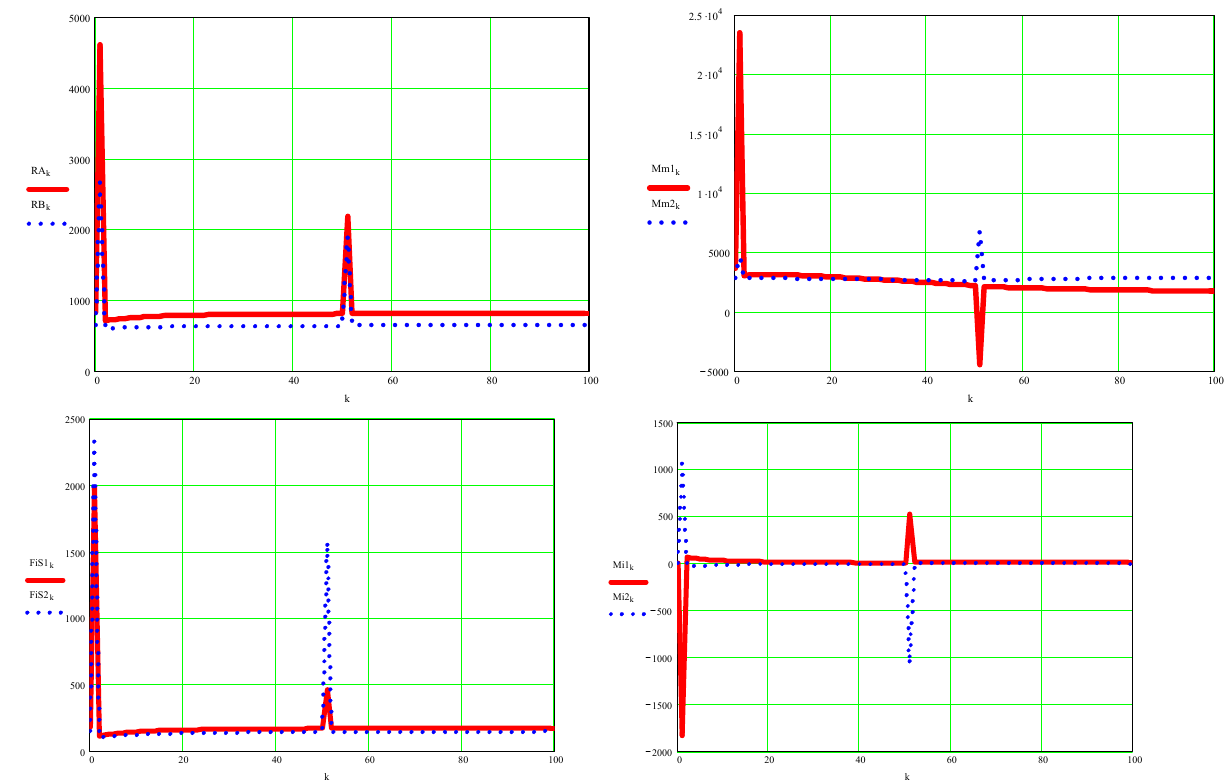
Figure A9. On the left are represented above the forces in the kinematic couples A (red) and B (blue) and below the inertial forces on element 1 (red) and 2 (blue), and on the right are the graphs of the motor moments at the top (red for element 1 and blue for element 2) and those of moments of inertia at the bottom. (7) Approximate classical dynamics (variable angular velocities and variable angular ac- celerations are determined; variation is due to inertial forces or variation in the masses of moving elements), Section 2.1.